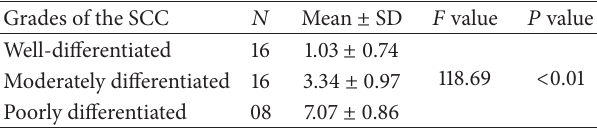
Table 3: Expression of podoplanin in OSCC (one-way ANOVA).